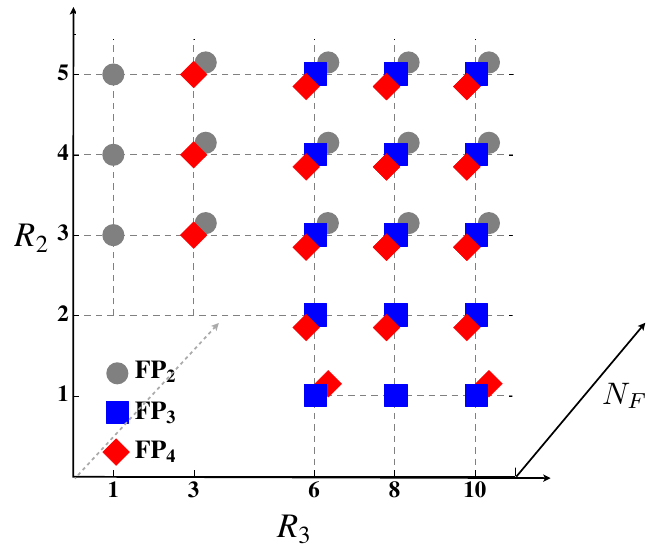
Figure 4 . Summary of weakly interacting UV (cid:12)xed points of (3.7) in dependence on the fermion representation and (cid:13)avor multiplicities ( R 3 ; R 2 ; N F ). The di(cid:11)erent symbols relate to FP 2 (gray circle), FP 3 (blue square) and FP 4 (red diamond). Overlapping symbols indicate that either type of (cid:12)xed point can exist, with lower-lying symbols relating to (cid:12)xed points which arise at a higher number of fermion (cid:13)avors N F , see also (cid:12)gure 2. FP 4 , while FP 2 is absent throughout. This holds true for all R 3 = 6 or higher, except for R 3 = 8 where only FP 3